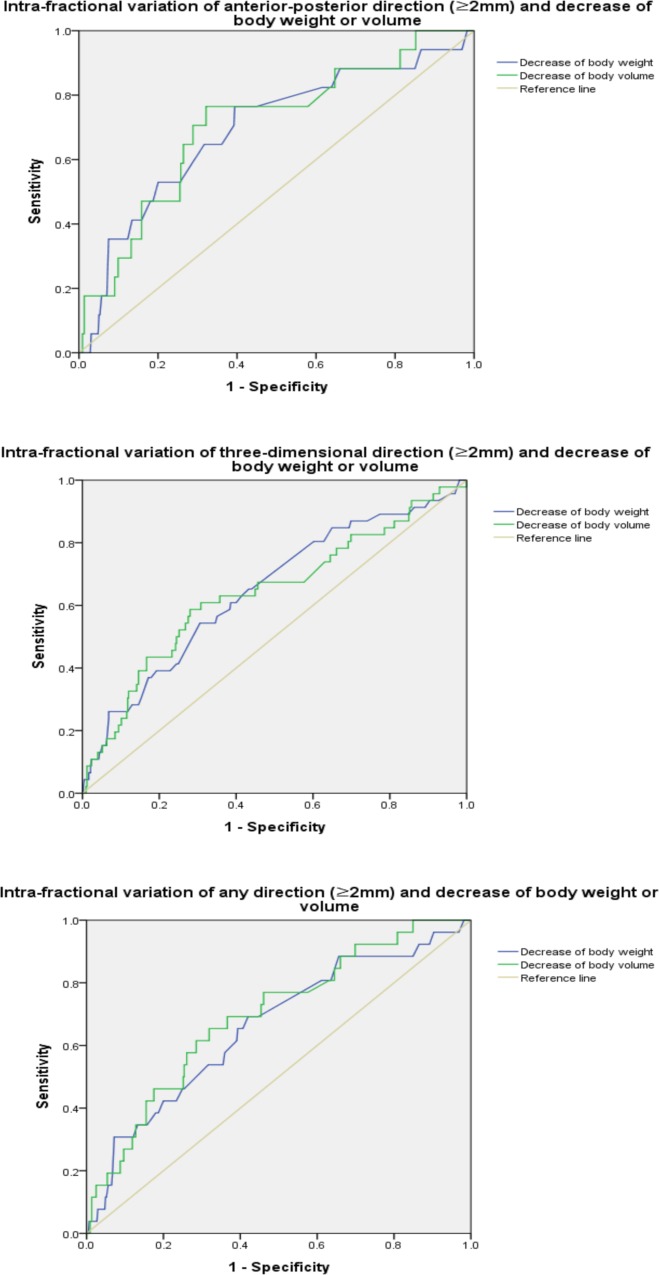
(A) Receiver operating characteristic curve of intra-fractional variations (≥2 mm) of anterior-posterior and decrease of body weight or volume. (B) Receiver operating characteristic curve of intra-fractional variations (≥2 mm) of three-dimensional vector and decrease of body weight or volume. (C) Receiver operating characteristic curve of intra-fractional variations (≥2 mm) of any directions and decrease of body weight or volume.